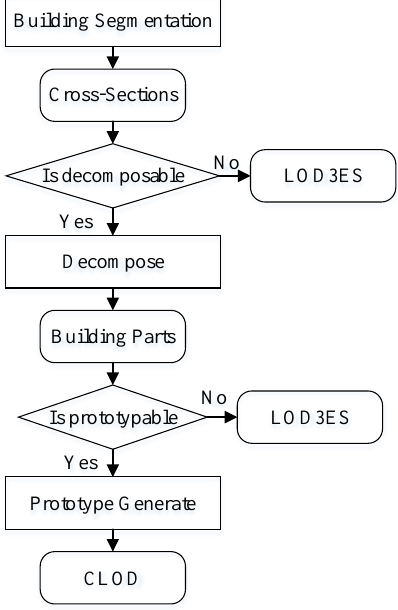
Figure 4. CLOD generation workflow.